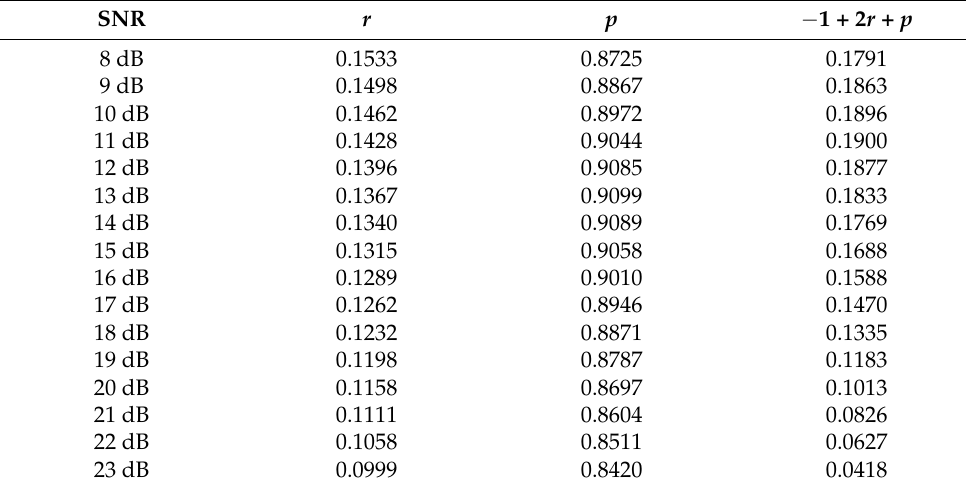
Table 3. Effect of r and p coefficient for four-way GPR